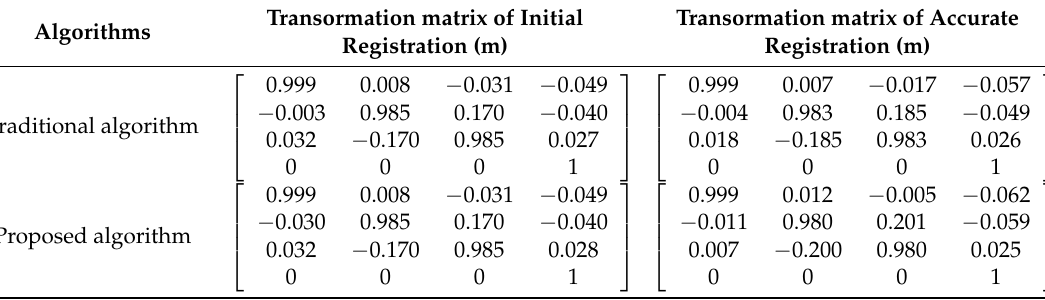
Table 2. Point cloud conversion results of different algorithms.